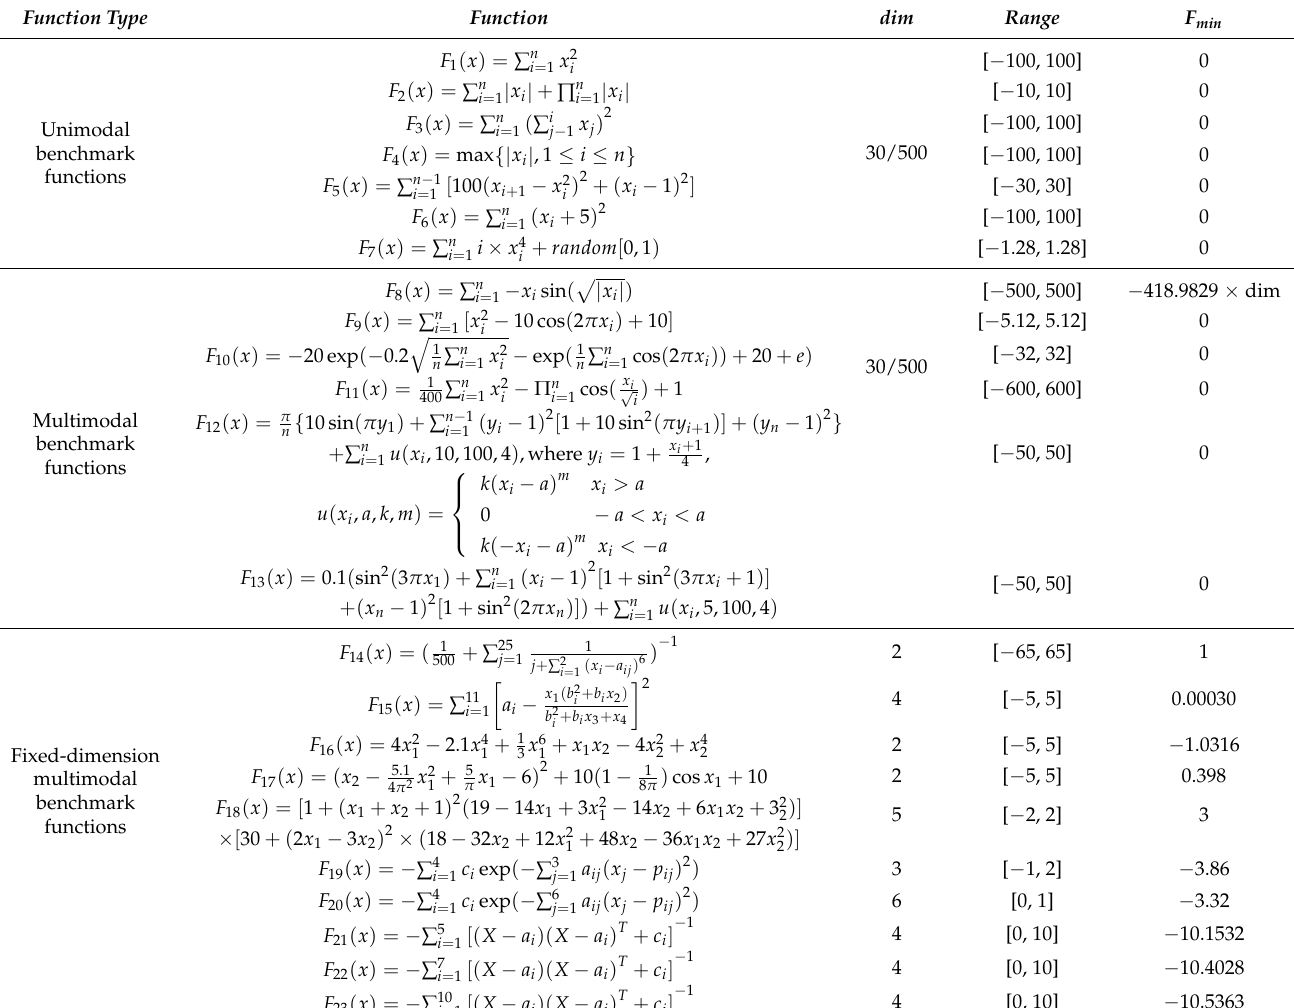
Table 2. Specific description of 23 standard benchmark